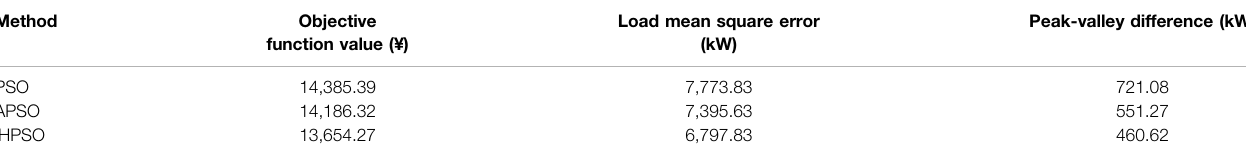
TABLE 3 | Optimized value of each objective